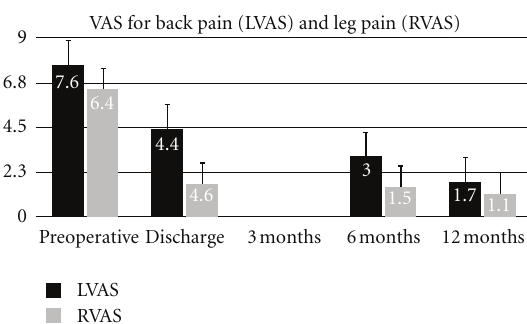
Figure 7: Clinical outcomes preoperatively and over 1 year postop- erative followup. Results are expressed as mean scores ± Standard deviation at each time point. LVAS: Low back visual analogue score (1–10) of pain, RVAS: radicular